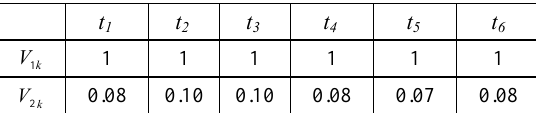
Table 6. Performance criteria of fashion